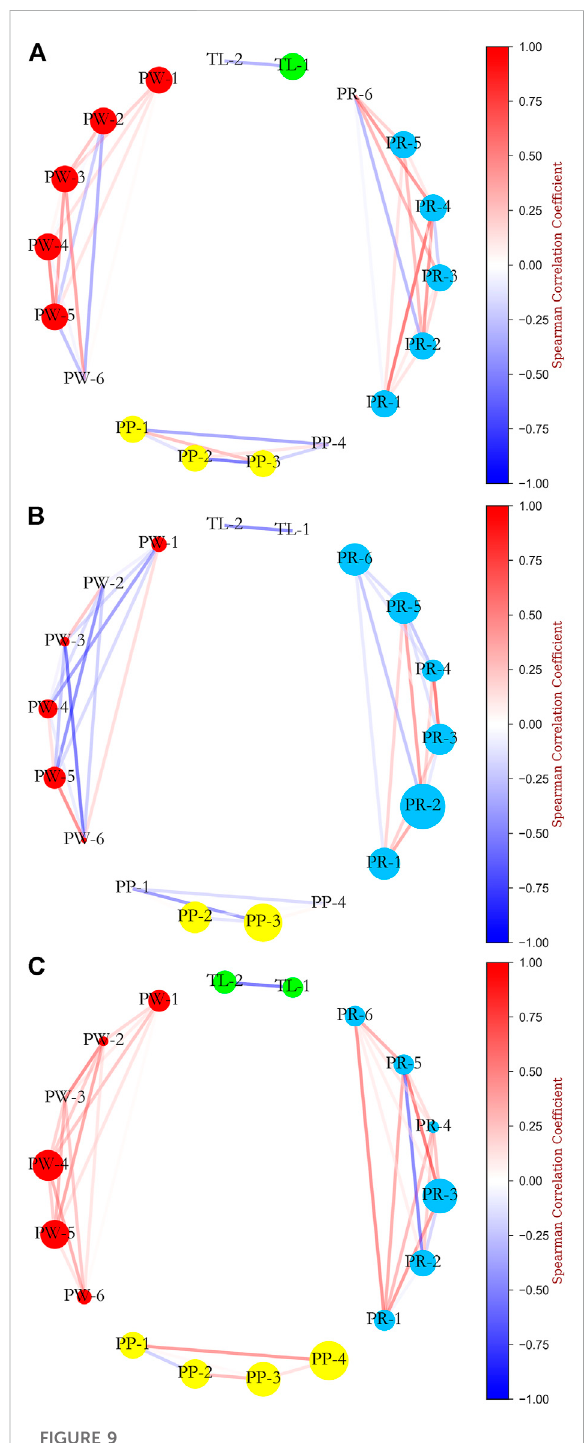
FIGURE 9 Network analysis of the relationship between SHAP values of independent variables: (A) non injured; (B) minimal LENCI risk versus non injured; (C) mild LENCI risk versus non injured.